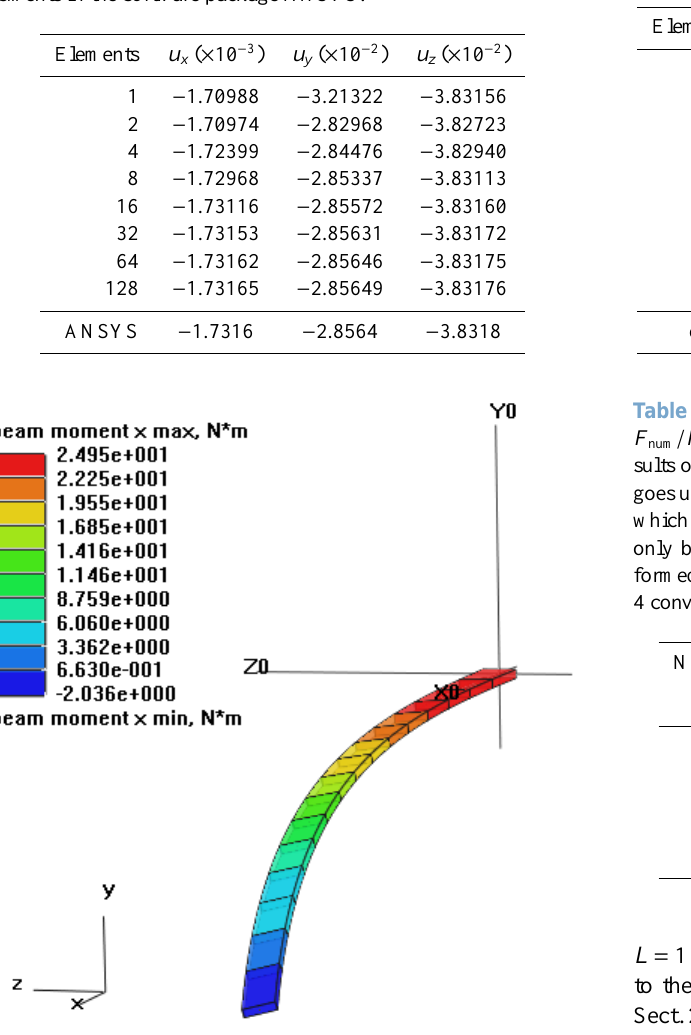
Table 3. Displacements u x and u y for the full circle bending in Sect. 6.4 converge at order 4.